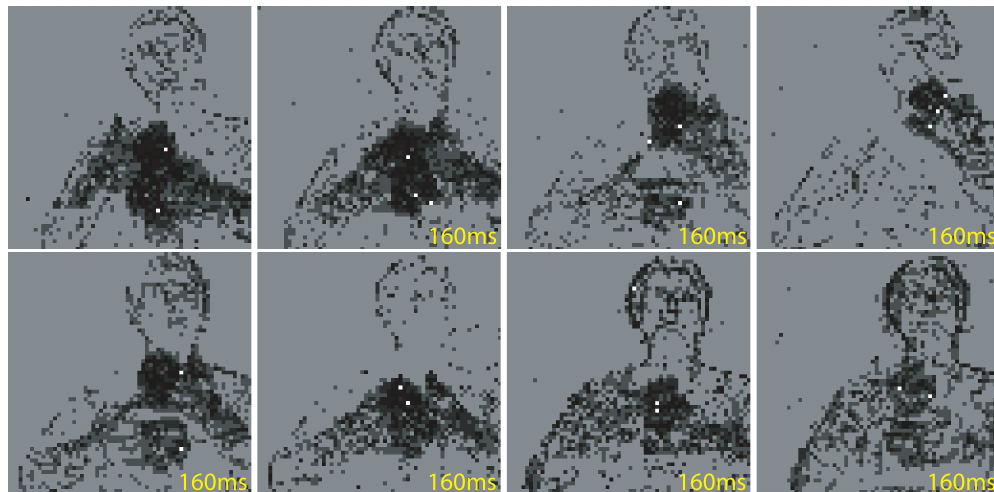
Figure 14 . Selective attention with natural moving stimuli (moving hands of a person): screen shots of the recorded activity from the retina (black and grey pixels) and selective attention chip (white pixels). The numbers on the bottom right of each screen shot correspond approximately to the time gap from the previous screen shot. The hands are highly salient objects as they produce a strong local response in the retina. The moving arms and shoulders of the person are not as salient because the activity they elicit is more distributed. The edges of the head are selected even more rarely (second last screen